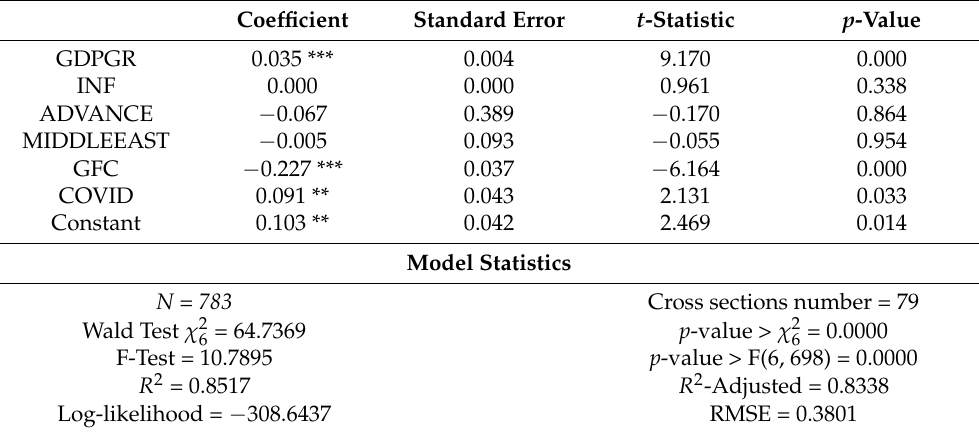
Table 6. Regression